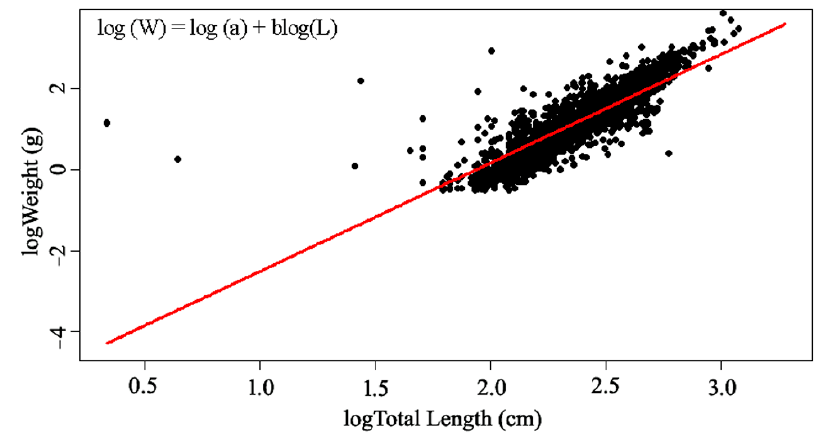
Figure 5. Length-weight relationship of the Bombay duck from the marine water of Bangladesh.